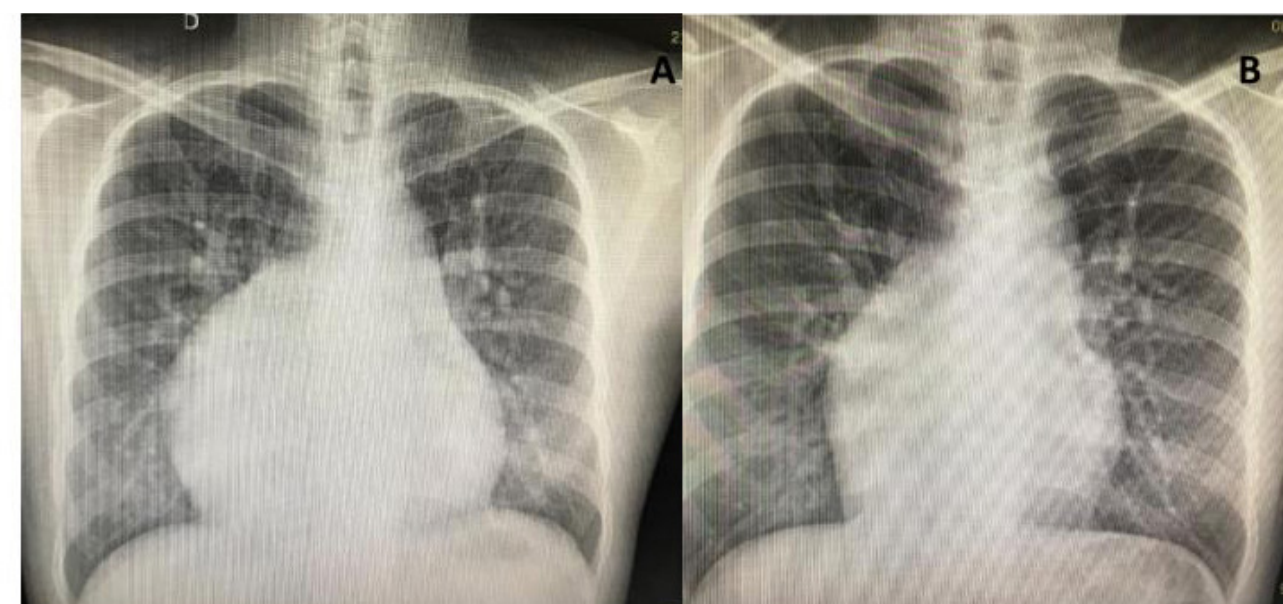
Fig. 7 - Preoperative (A) and three-year postoperative (B) chest radiographs in a currently well 31-year-old patient with congenitally corrected transposition of the great arteries and a mesocardiac positioned heart submitted to a large atrial septal defect closure plus a mechanical tricuspid valve replacement (same patient of Figure